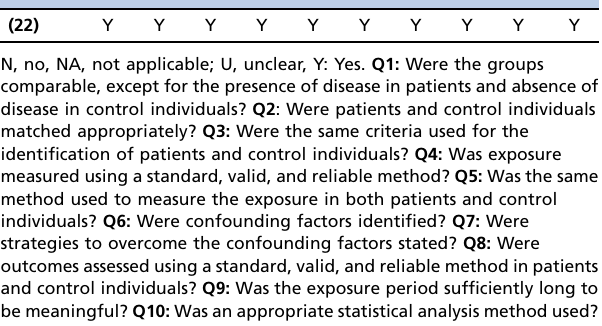
Table 4 - Results of the critical assessment of included studies (case–control) using the Joanna Briggs Institute approach.